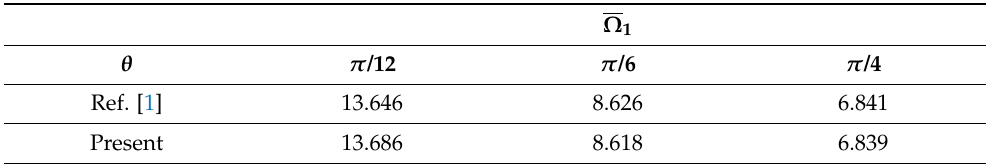
Table 2. The fundamental natural frequency parameter Ω 1 for an isotropic isosceles triangular plate with CCC boundary conditions.